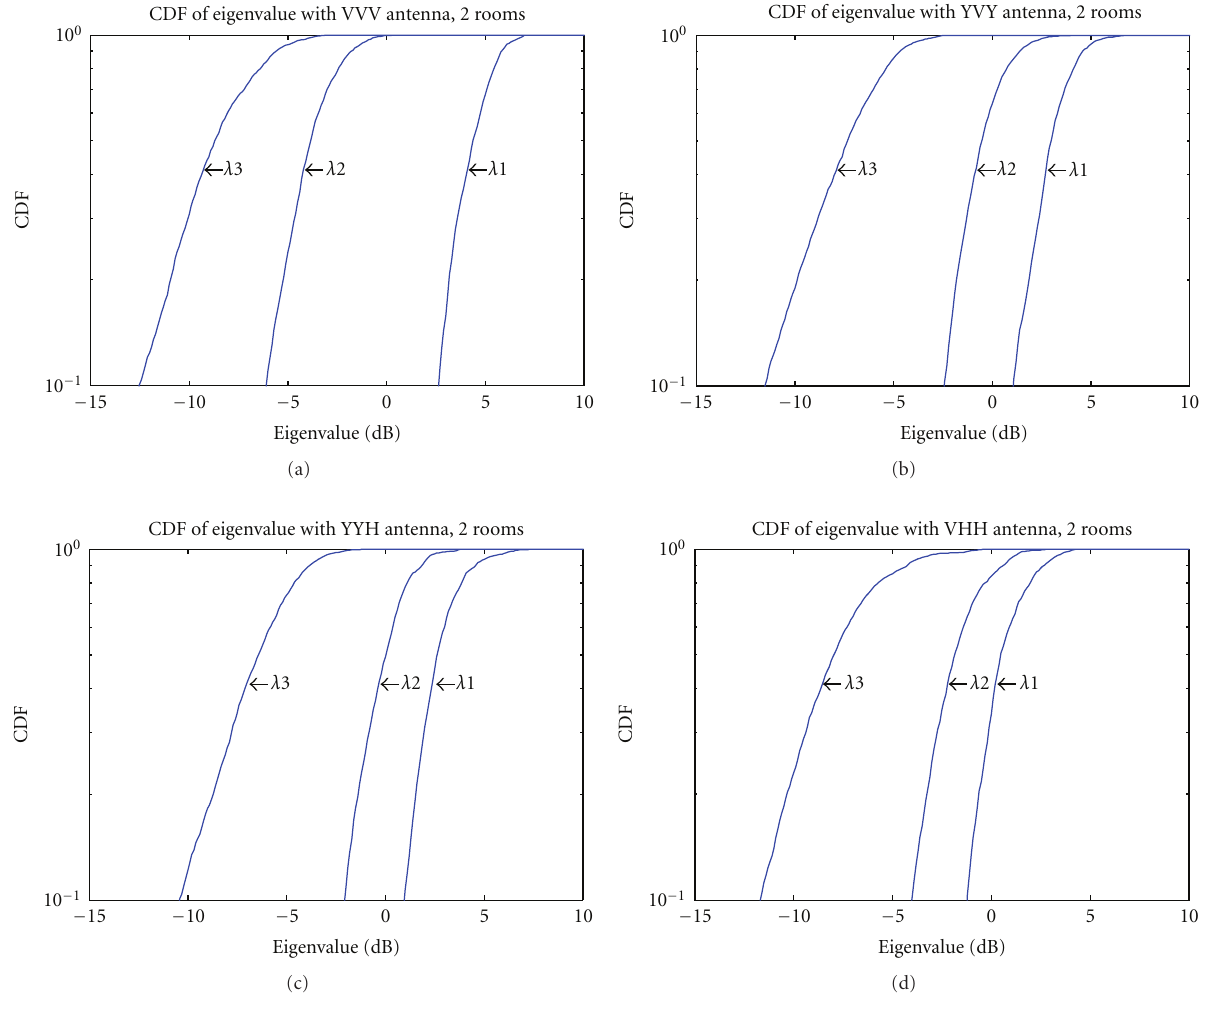
Figure 7: The plots of CDF versus eigenvalues when the polarization system employing (a) VVV (b) YVY (c) YYH (d) VHH cases in NLOS indoor